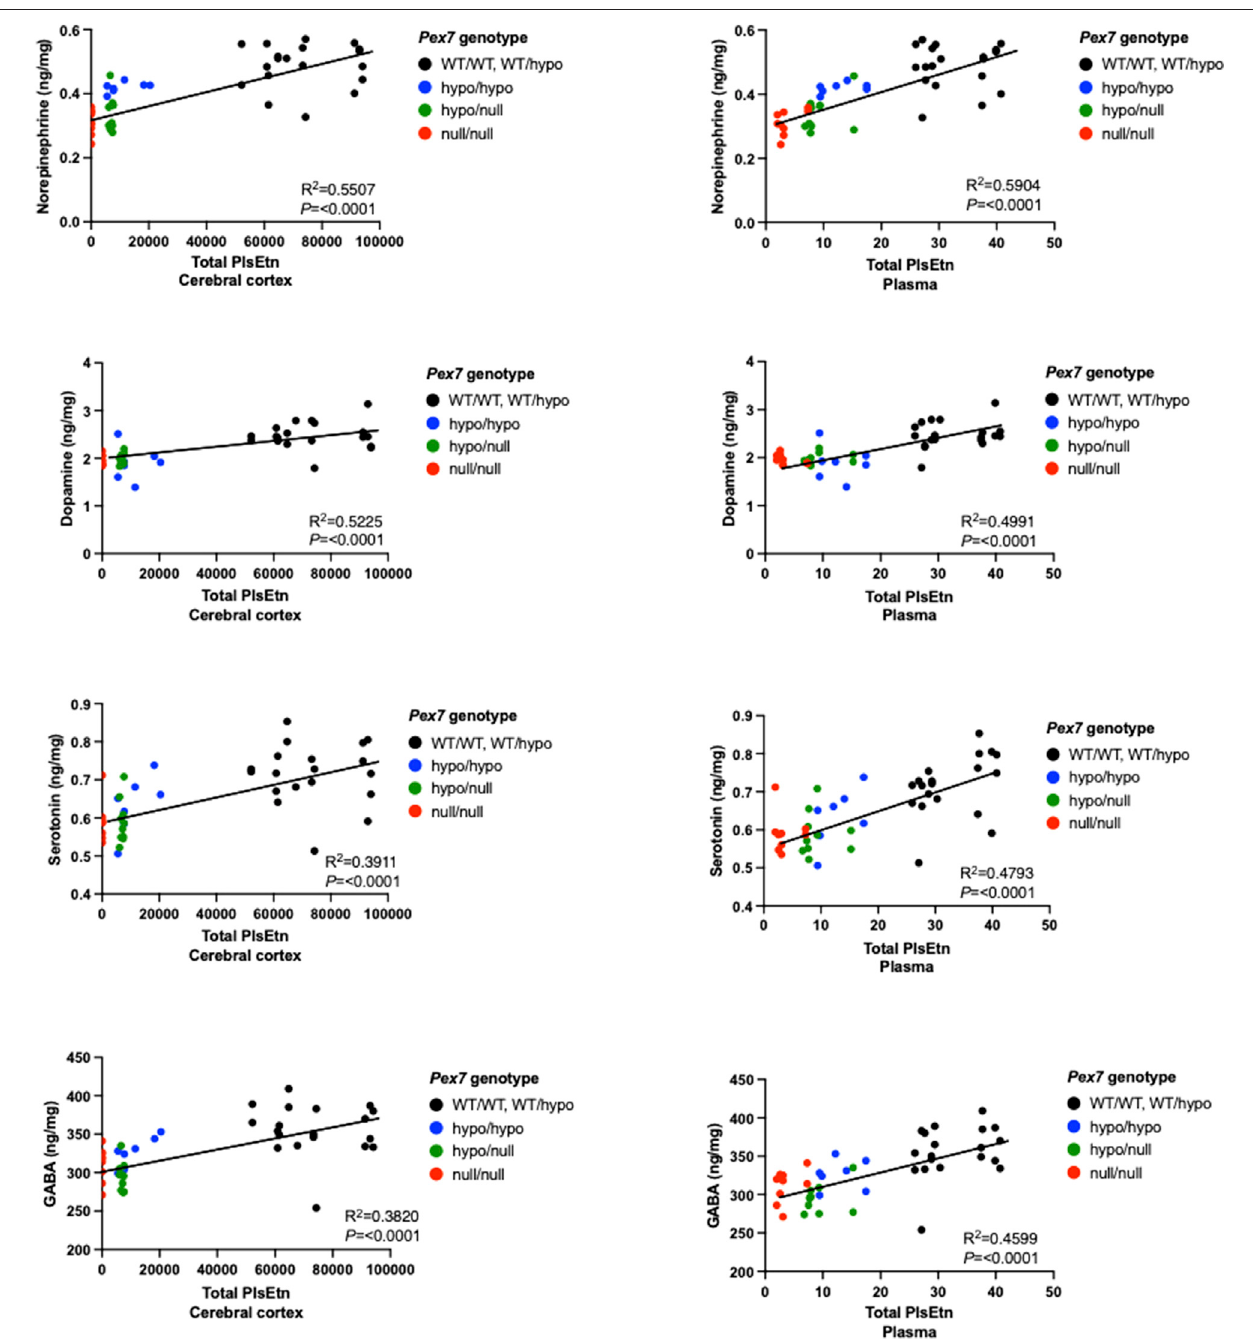
FIGURE 11 | Brain neurotransmitter de fi cits correlate with total Pls levels in plasma and cerebral cortex samples from Pex7 de fi cient mice. A signi fi cant positive correlation was found between the brain neurotransmitter levels and total PlsEtn measurements in plasma and cerebral cortex tissue from Pex7 de fi cient mice. Total PlsEtn in cerebral cortex was measured as (nmol/mg protein) and in plasma was measured as (pmol). **** p < 0.0001 ( n = 8 – 10 per genotype).